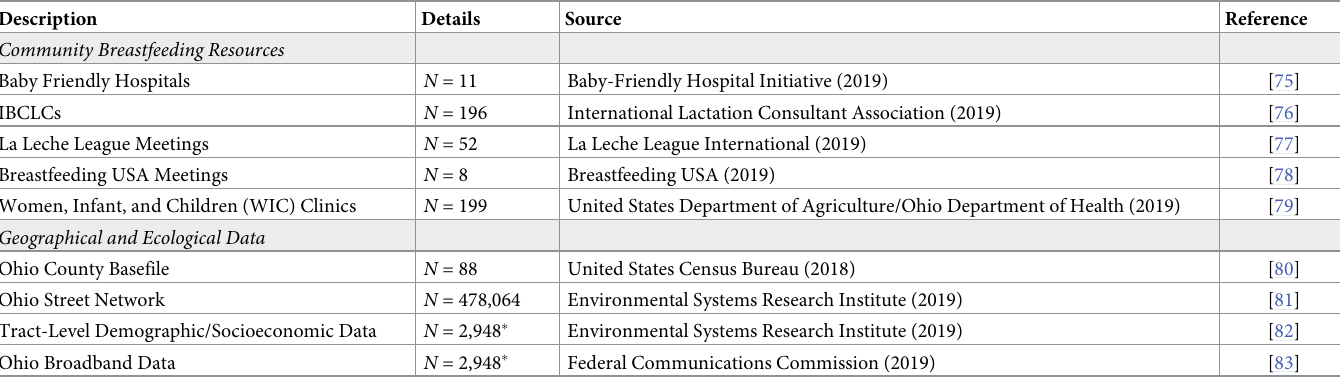
Table 3. Data sources.